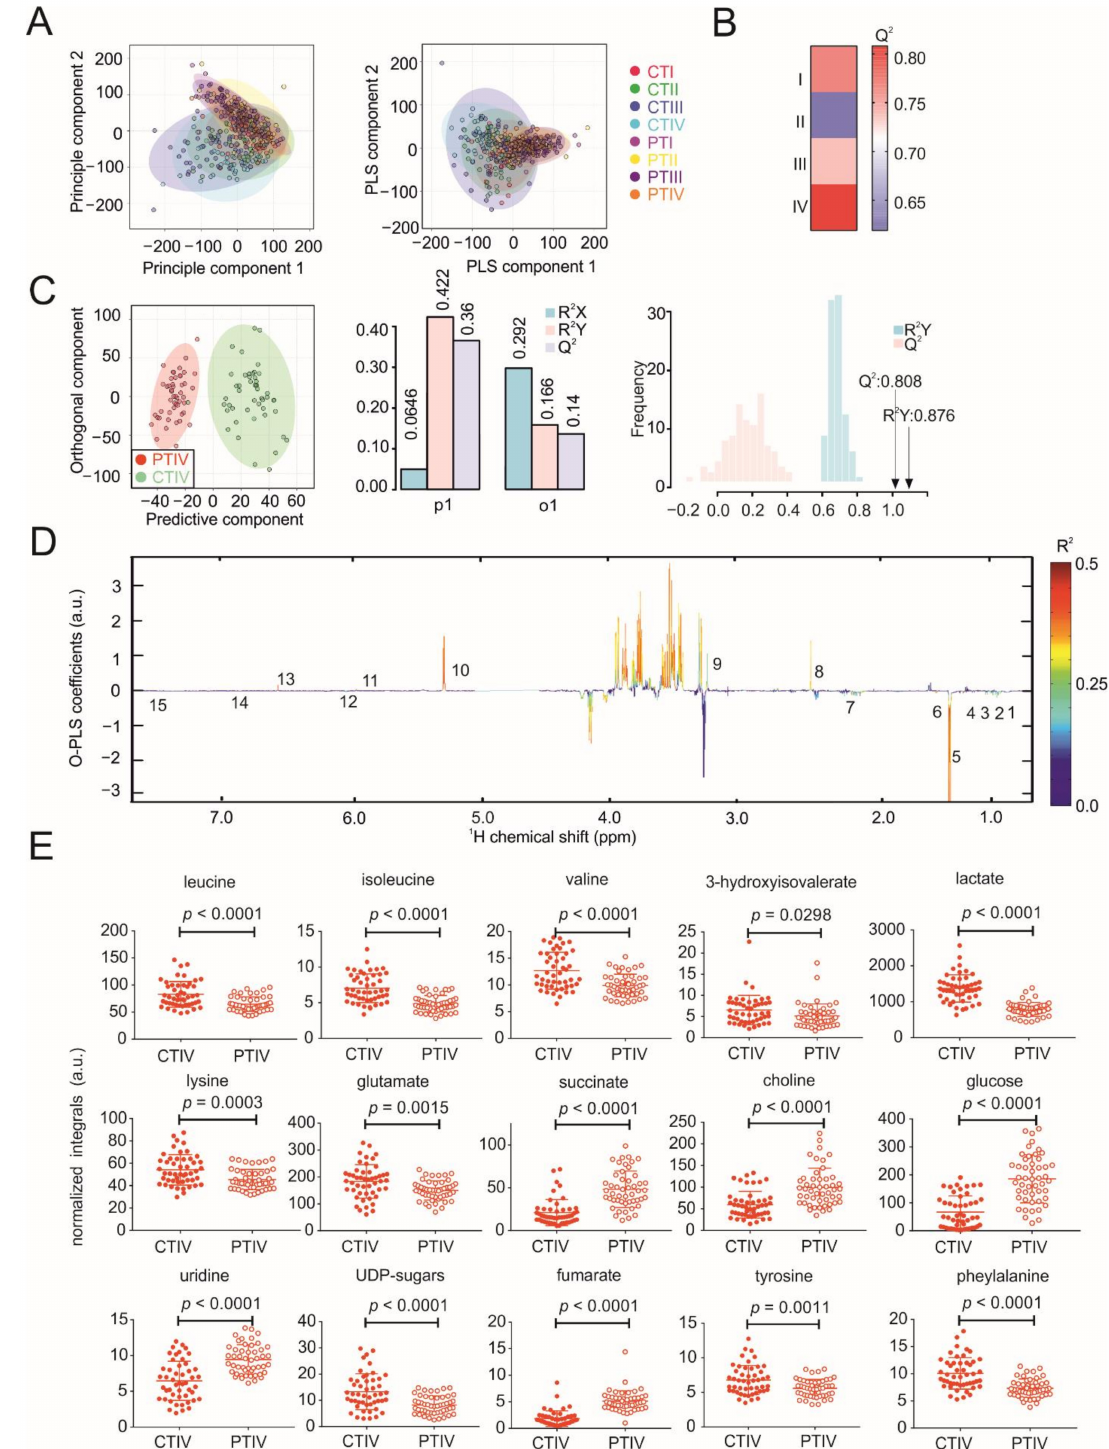
Figure 3. NMR metabolomics analysis of the tissue samples. ( A ) PCA and PLS-DA plots of tissue samples (grade IV carcinoma tissues (CTIV) and peritumoral tissues (PTIV)). ( B ) Heatmap showing O-PLS-DA-derived Q 2 for pairwise comparisons of the tissue samples. ( C ) O-PLS-DA plot of the tissue samples, including a cross-validation. ( D ) The reduced NMR spectrum reveals altered components in the normalized tissue samples. Positive covariance corresponds to the